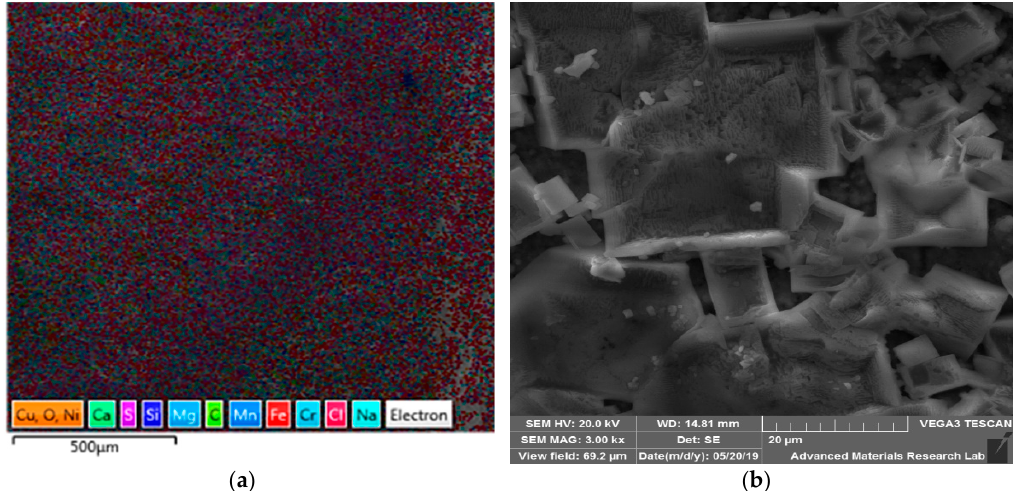
Figure 5. EDS and SEM for HT specimen; ( a ) specimen HT-EDS mapping for 316LSS HAZ; ( b ) specimen HT-SEM on SS HAZ